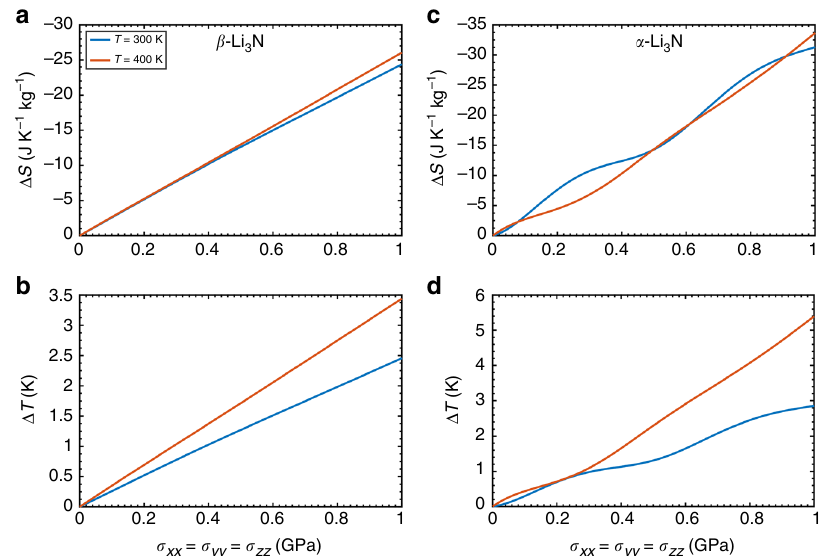
Fig. 2 Direct barocaloric effects in Li 3 N. a Isothermal entropy and b adiabatic temperature shifts estimated in β -Li 3 N. c Isothermal entropy and d adiabatic temperature shifts estimated in α -Li 3 N